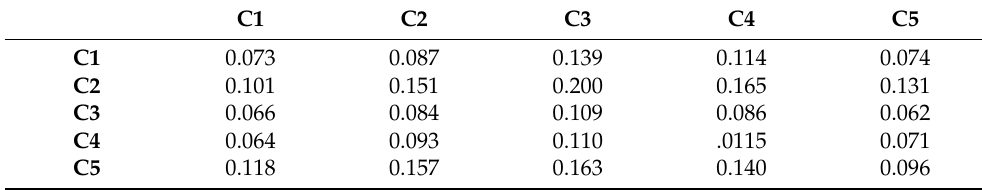
Table A7. Total relation matrix of